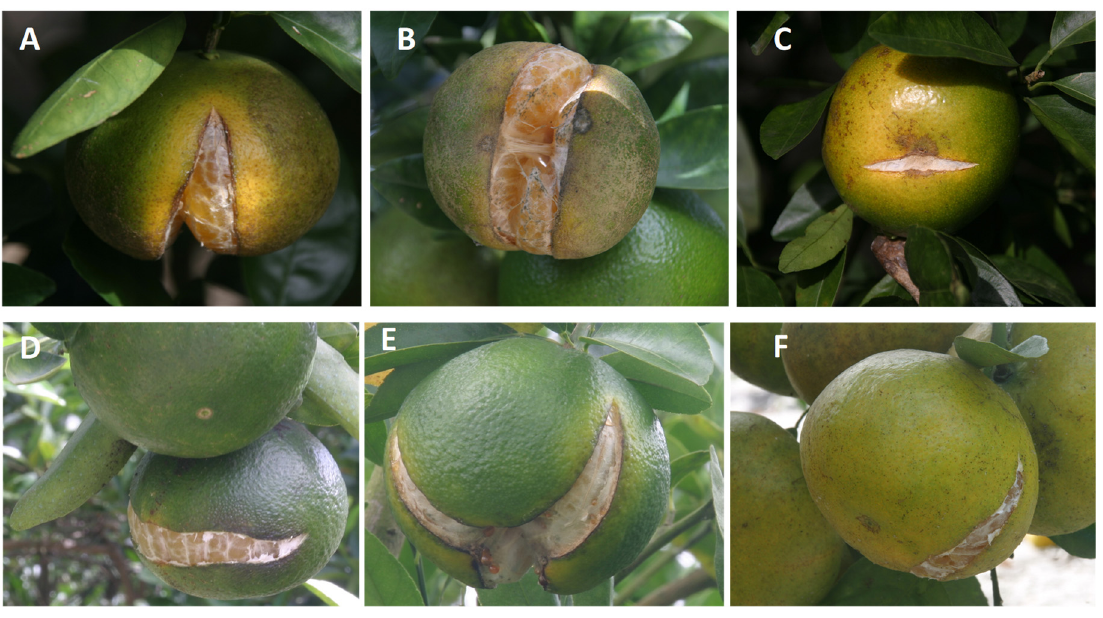
Figure 1. Variation in fruit split in Murcott mandarins. The longitudinal splits through navel ( A – C ) are common. Transverse splits are less common ( D ), and tripartite splits ( E ) and off-center splits ( F ) are typically uncommon.